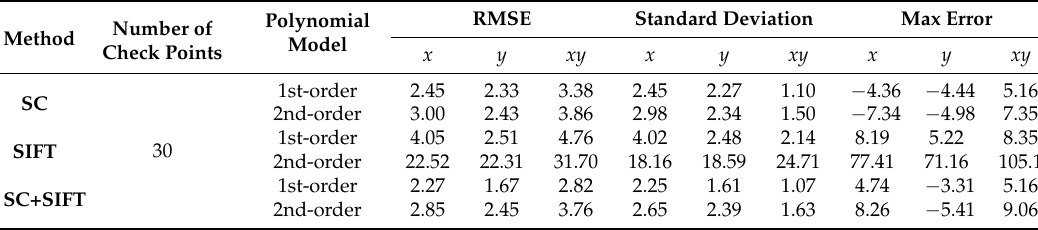
Table 2. Quantitative Results of Check Points.